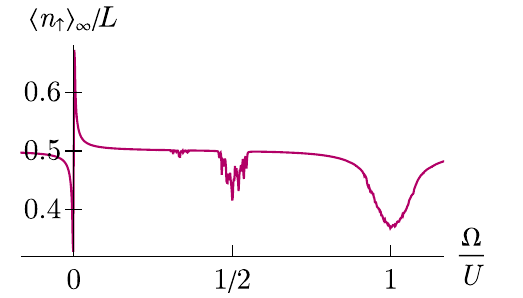
FIG. 14. Long-time average population (cid:12)ˆ n ↑ (cid:4) ∞ for the n = 2 system with the different initial state | ˜ ψ 0 (cid:4) from Eq. (B2). The parameters are L = 9, U / J = 30, φ = π/ 2, and time averaging is done out to tJ =